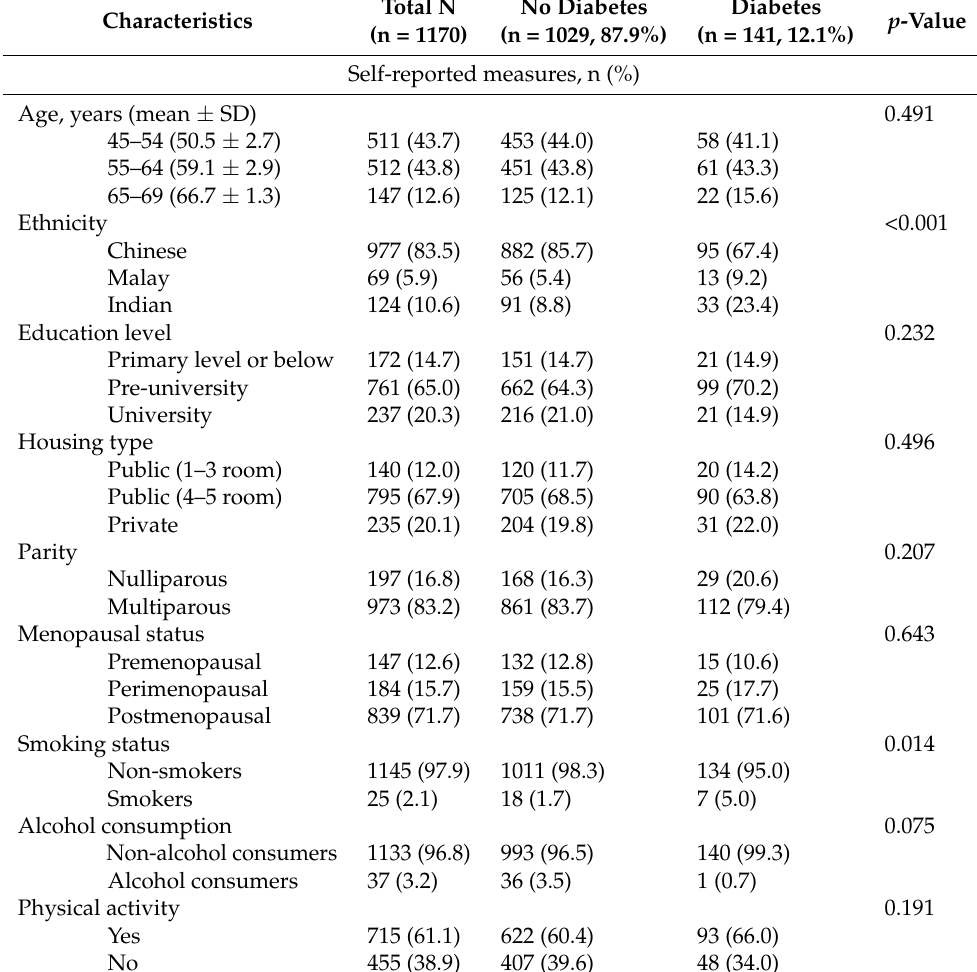
Table 1. Participant